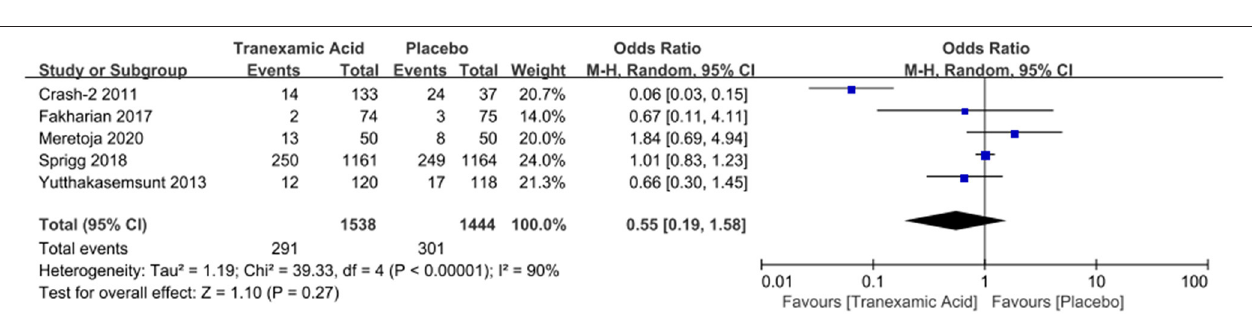
FIGURE 4 | Forest plot of the comparison between tranexamic acid and placebo treatments for the mortality.